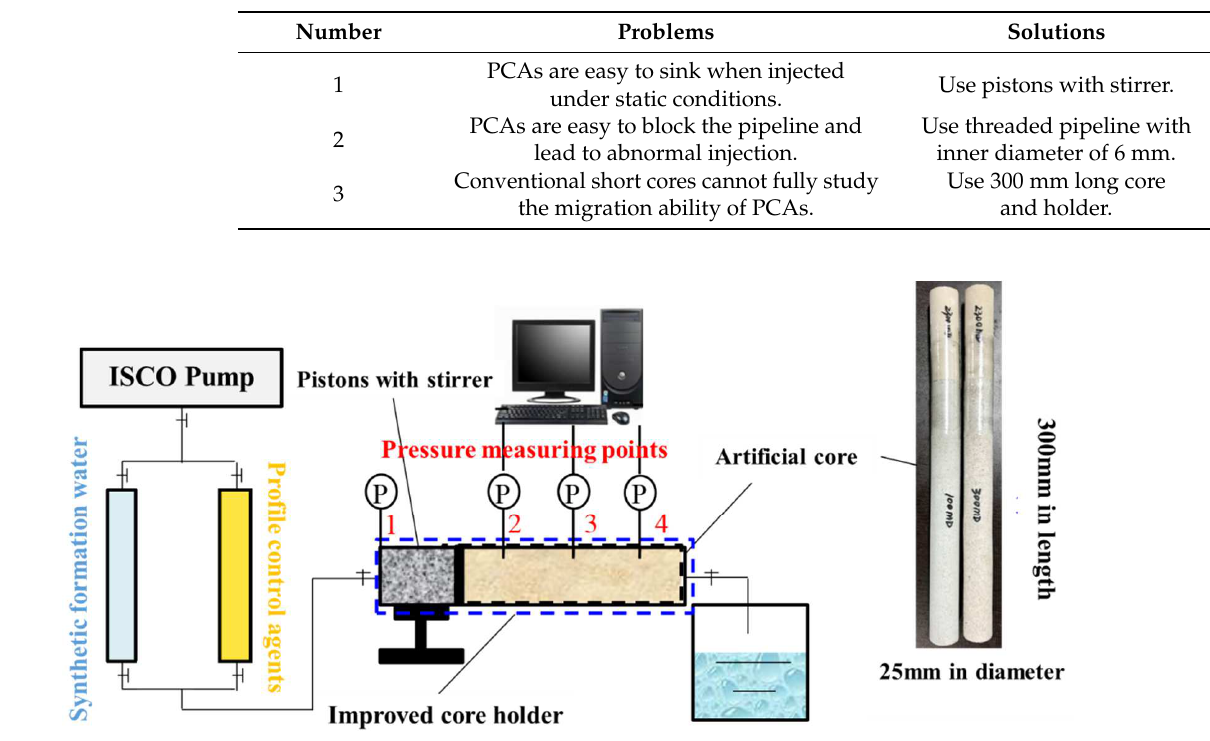
Table 19. Problems and solutions in the experiments.